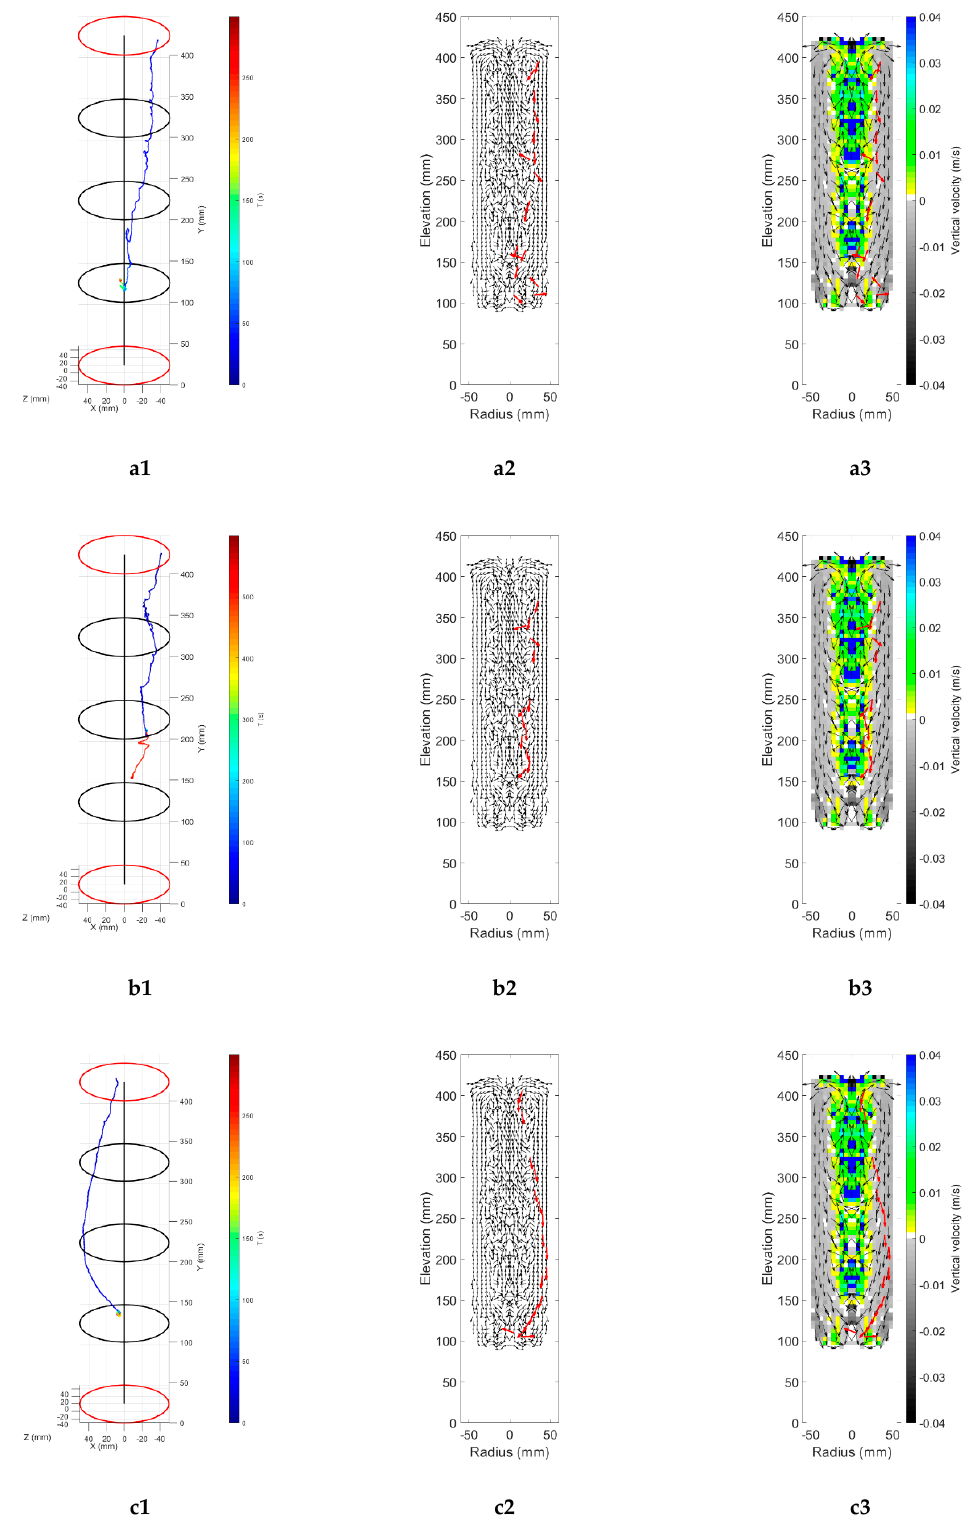
Figure 3. The results of 3 runs ( a – c ) of − 300 + 212 µm hematite particle for an airflow rate of 1.25 u mf (Lagrangian trajectory (1) and Eulerian flow maps (2 and 3)).